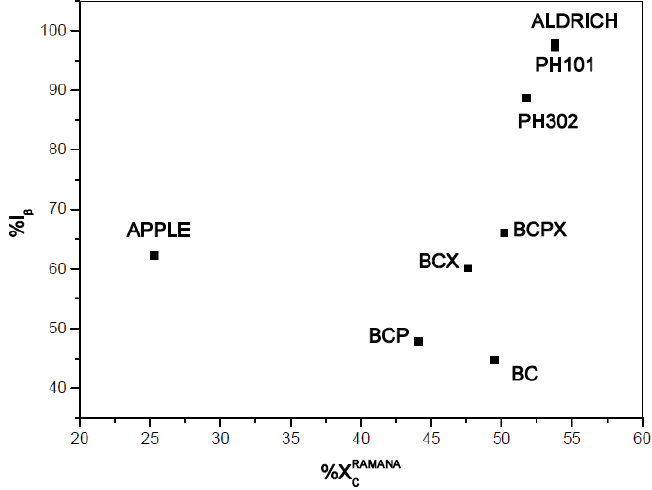
Figure 7. Dependence of cellulose degree of crystallinity from percentage content of cellulose I